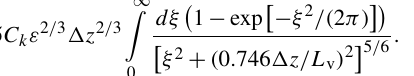
Figure 4. Dependency of L v on σ 2 t σ − 2 v according to Eq. (28) (black curve) and the residuals of the power-law fit according to Eq. (32) (gray line). Table 2. Adjusted parameters for dissipation rate retrieval from RHI